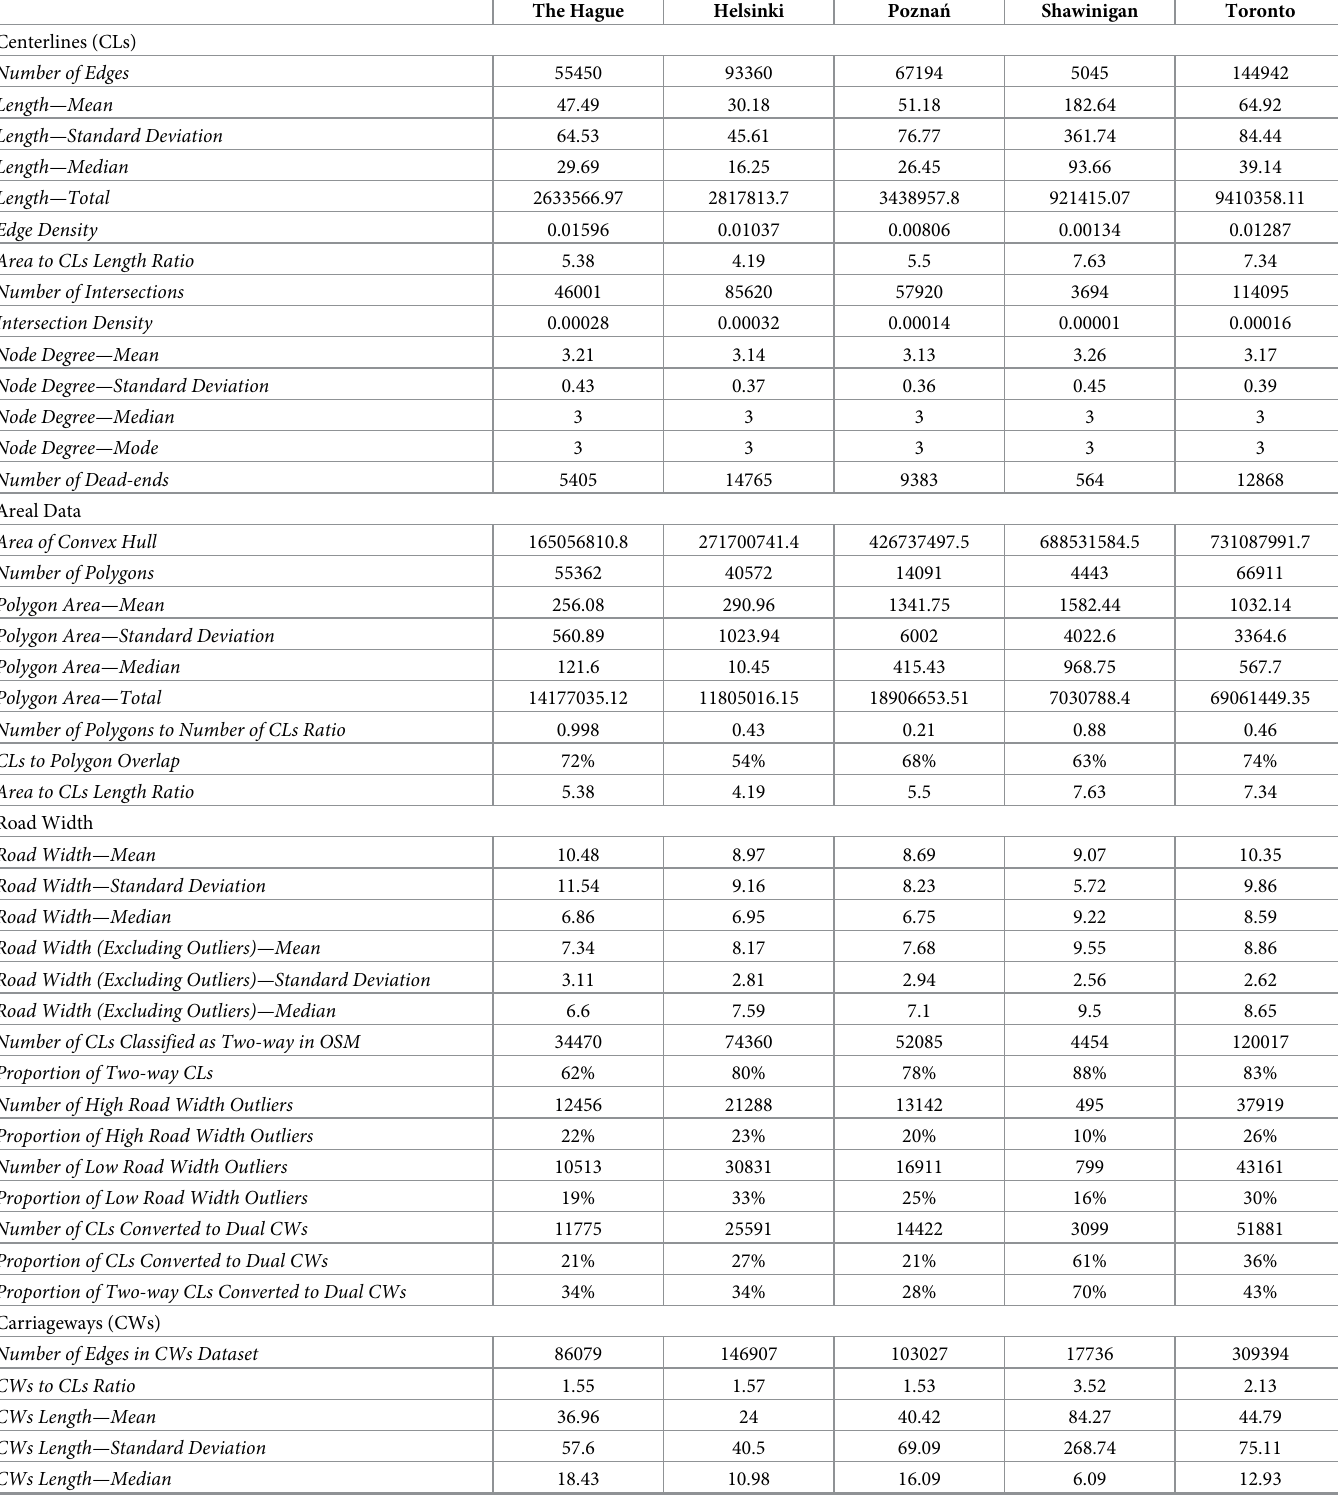
Table 4. Network measures of the road datasets and comparisons between them. Lengths and areas are measured in m and m 2 , respectively. The Hague Helsinki Pozna